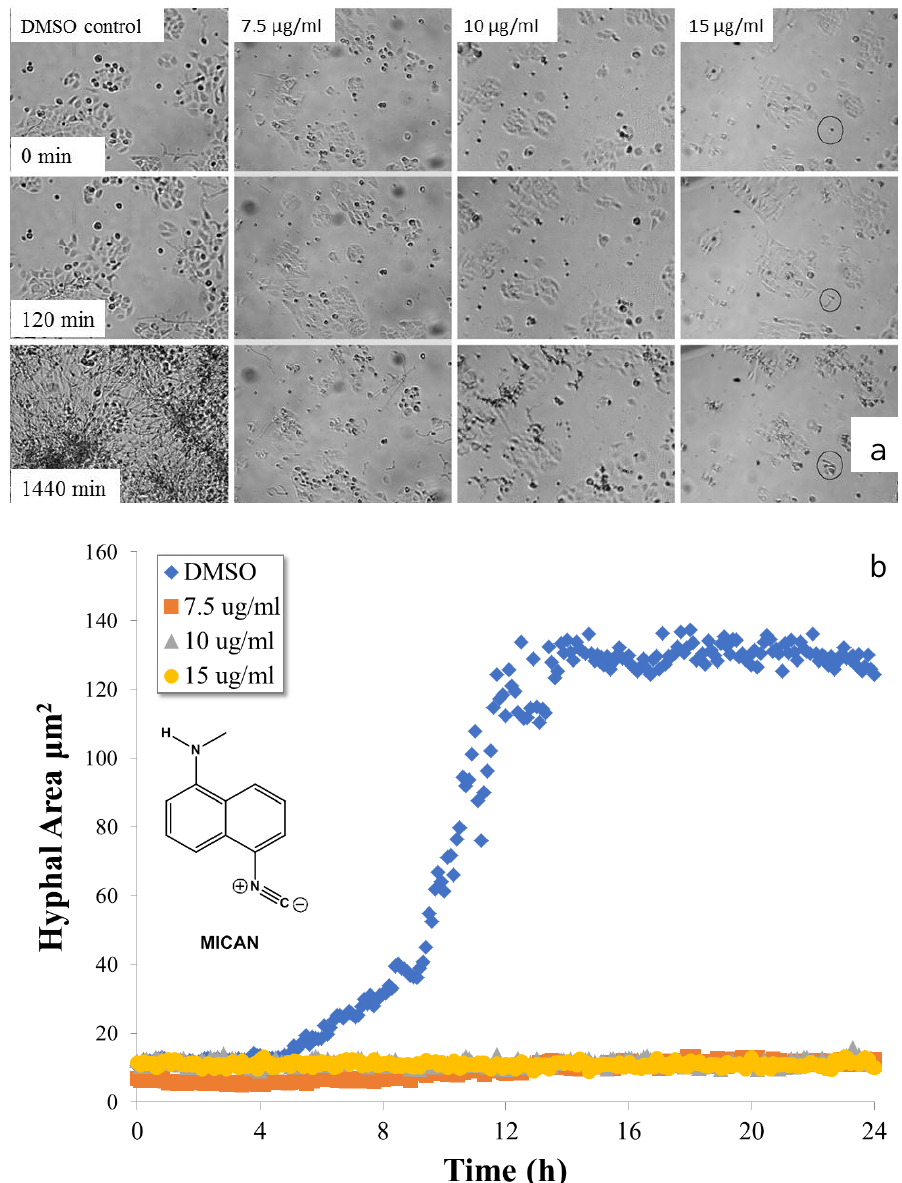
Figure 1. Hyphal growth of C. albicans in the presence of methylamino-5-isocyanonaphthalene (MICAN). Time-lapse microscopic images ( a ) of HaCat cells infected by C. albicans in the presence of different concentrations of MICAN and the corresponding hyphal growth curves ( b ) determined from the average individual hyphal area of C. albicans . (Areas were measured instead of lengths due to the hyphal ramifications).